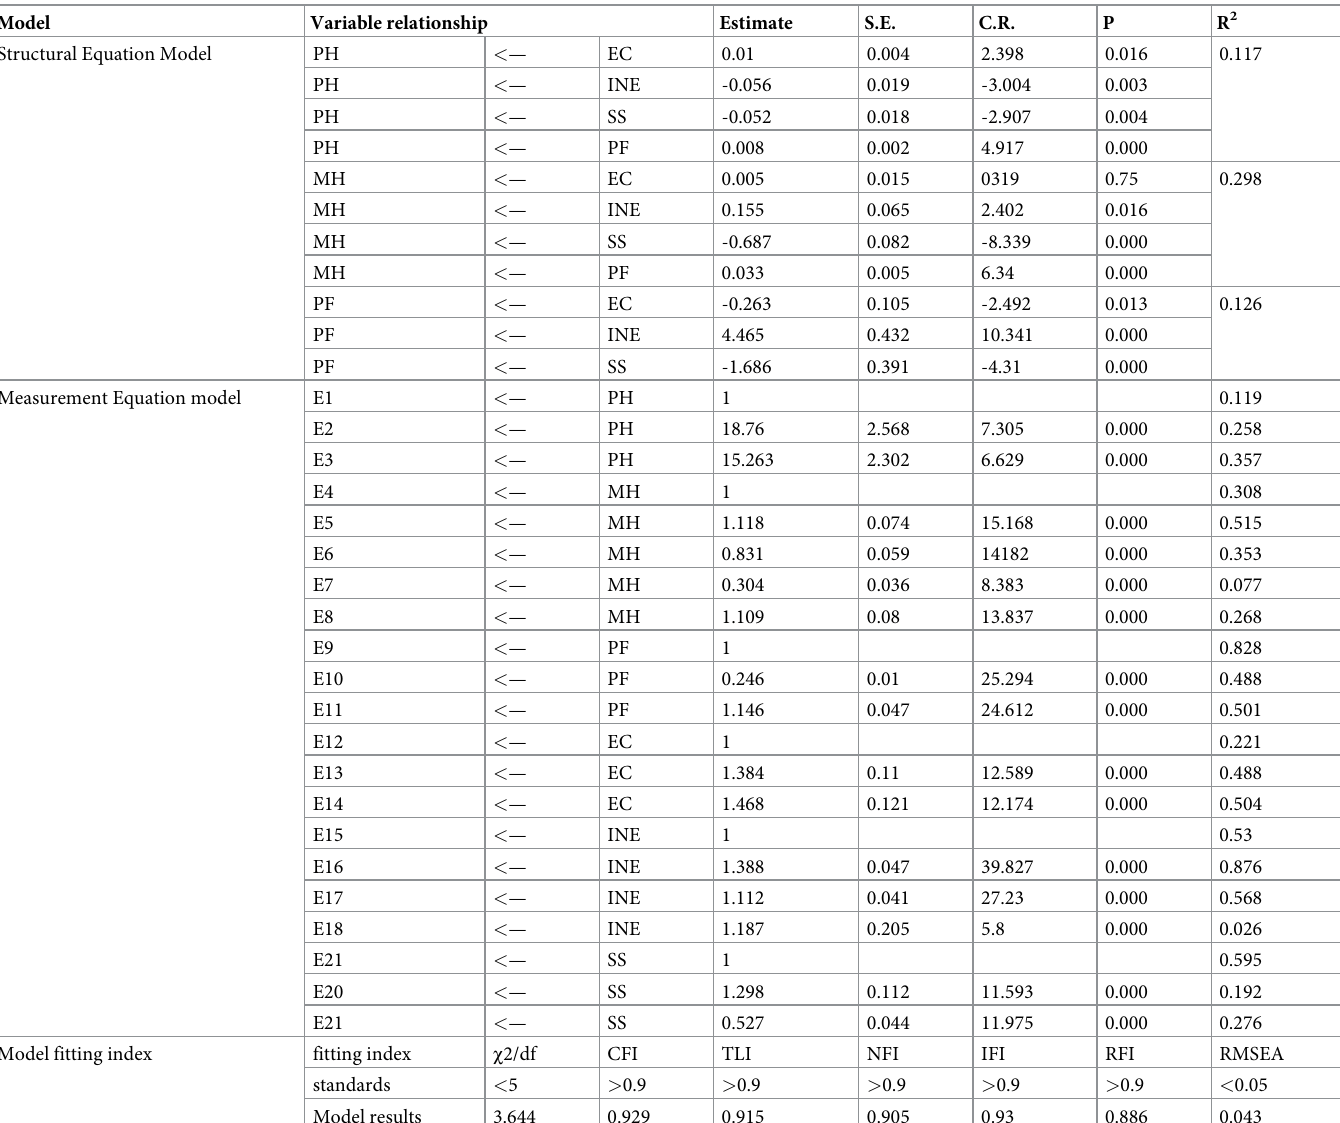
Table 2. Parameter estimation for structural equation model (N =